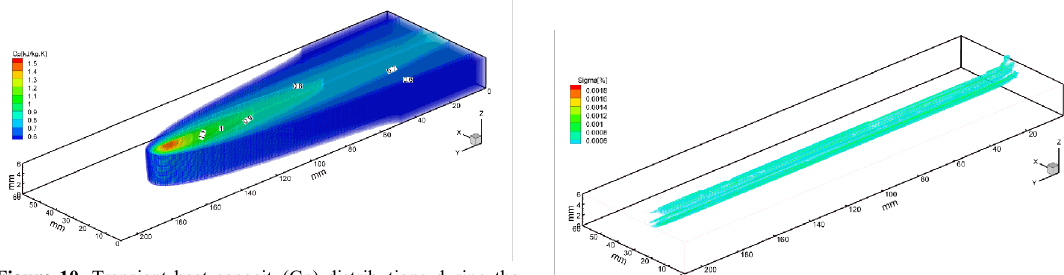
Figure 10. Transient heat capacity(Cp) distributions during the finishing welding pass (time = 32 s and heat input =1.2 kJ mm -1 ).